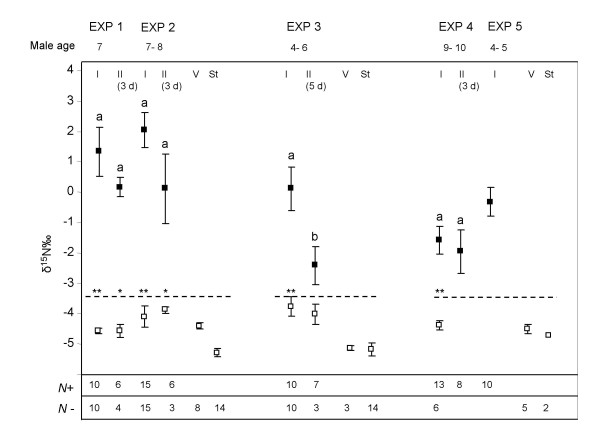
Mean ± s.e.m. δ15N‰ values of spermathecae of inseminated (filled symbols) and uninseminated (open symbols) females from experiments 1–5. Male age at the start of the experiment is given. N is the number of spermathecae analysed for inseminated (+) and uninseminated (-) females. The dotted line indicates the threshold value of 3 s.d. above mean δ15N‰ of virgin females. Virgin (V) and Standard (St) samples are included. Dissection treatments are: I: females dissected immediately after mating; II: females isolated and dissected 3–5 days after mating (with the number of days used added in between brackets). Values with different letters are significantly different at p < 0.05 with comparisons made between dissection treatments I and II for each experiment. Asterisks indicate significant difference between spermathecae of inseminated and uninseminated females for each treatment at * p < 0.05, and ** p < 0.01 (comparisons made with independent t-tests or Mann-Whitney U tests).